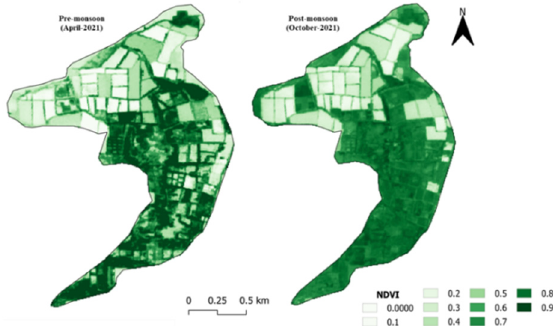
Figure 3. Spatial Variations of Normalised Difference Water Index (NDWI) and Normalised Difference Vegetation Index (NDVI) over Keshopur Wetland for year 2021 during pre- and post-monsoon season.